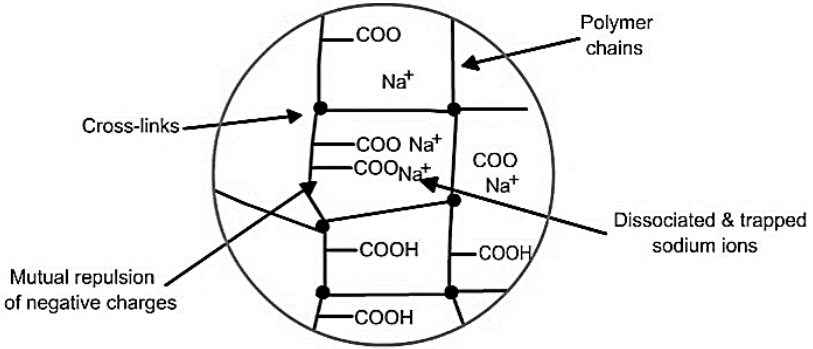
Figure 11. Mechanism of water absorption in super-absorbent polymers (SAP).